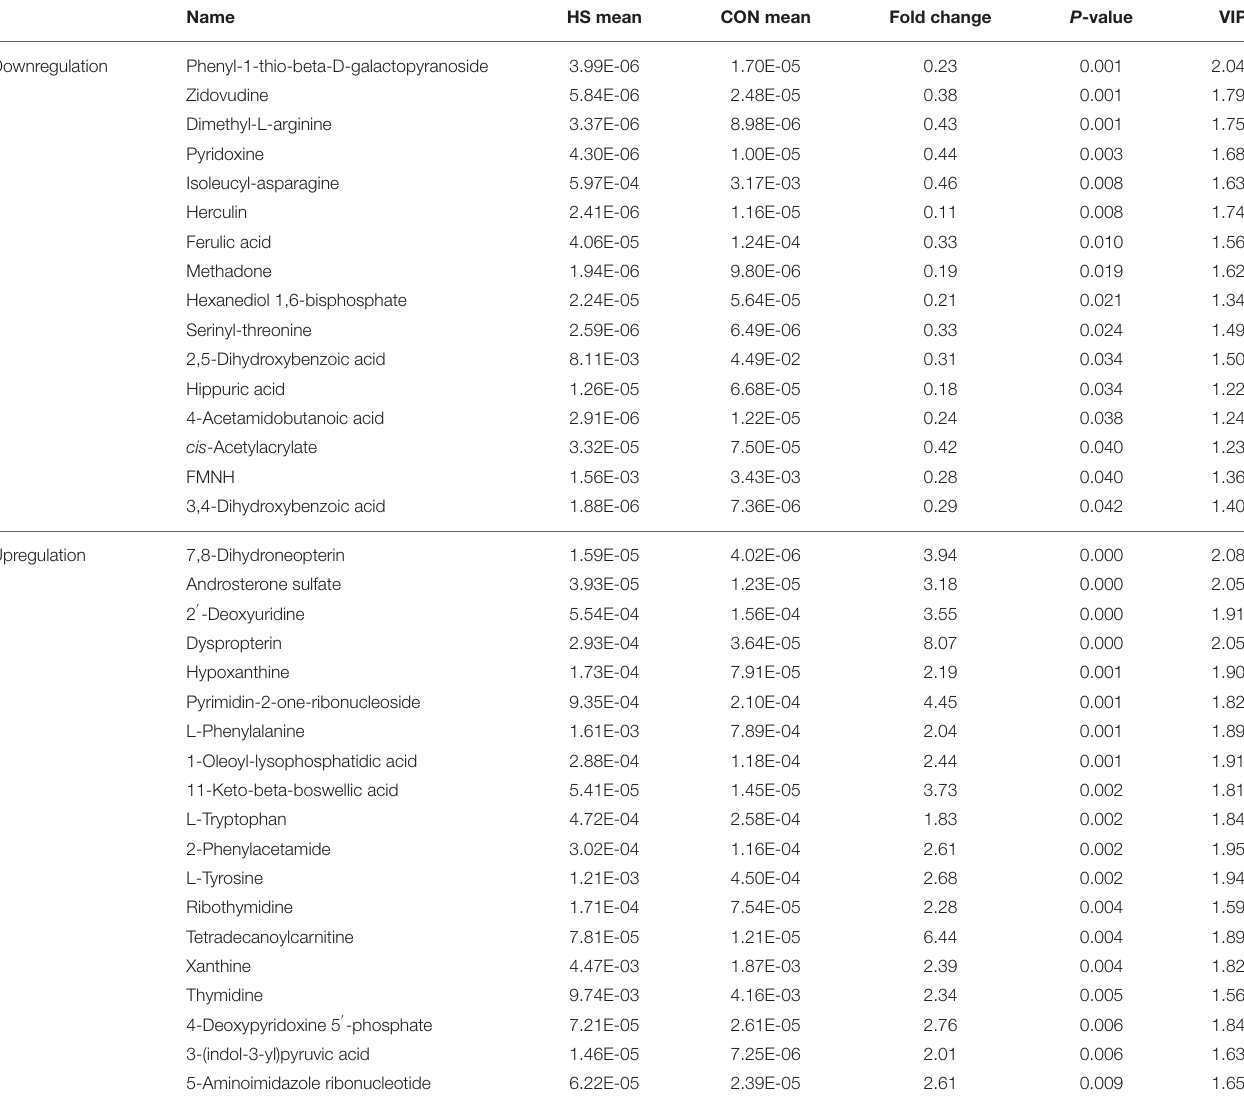
TABLE 8 | Ruminal metabolite alterations under heat stress